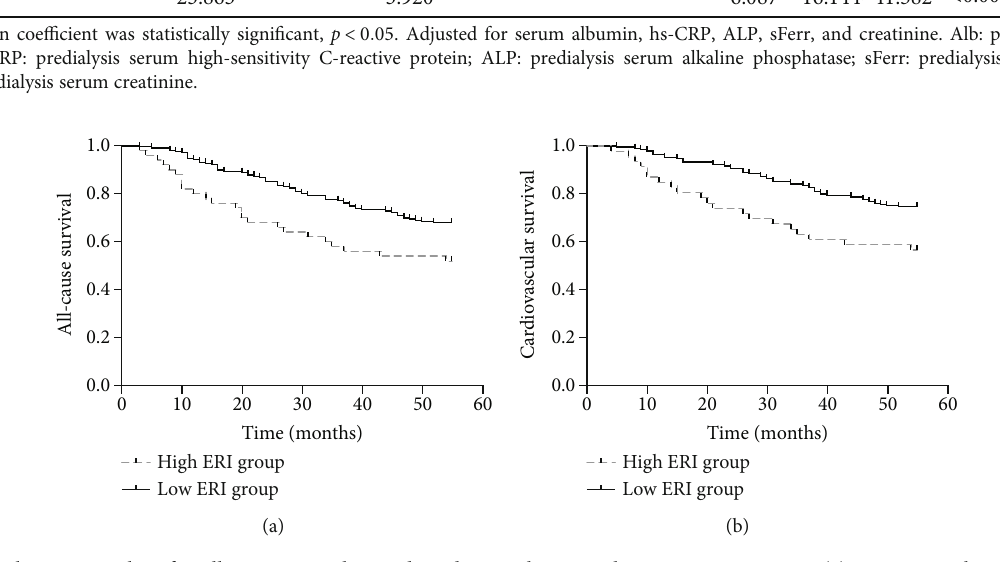
Figure 1: Kaplan – Meier plots for all-cause mortality and cardiovascular mortality in MHD patients. (a) Patients with ERI > 11 : 04 had signi fi cantly higher all-cause mortality ( log rank = 6 : 719 ; p < 0 : 01 ). (b) Patients with ERI > 11 : 04 had signi fi cantly higher cardiovascular mortality ( log rank = 7 : 800 ; p < 0 : 01 ). Table 4: Cox proportional HR for all-cause mortality and cardiovascular